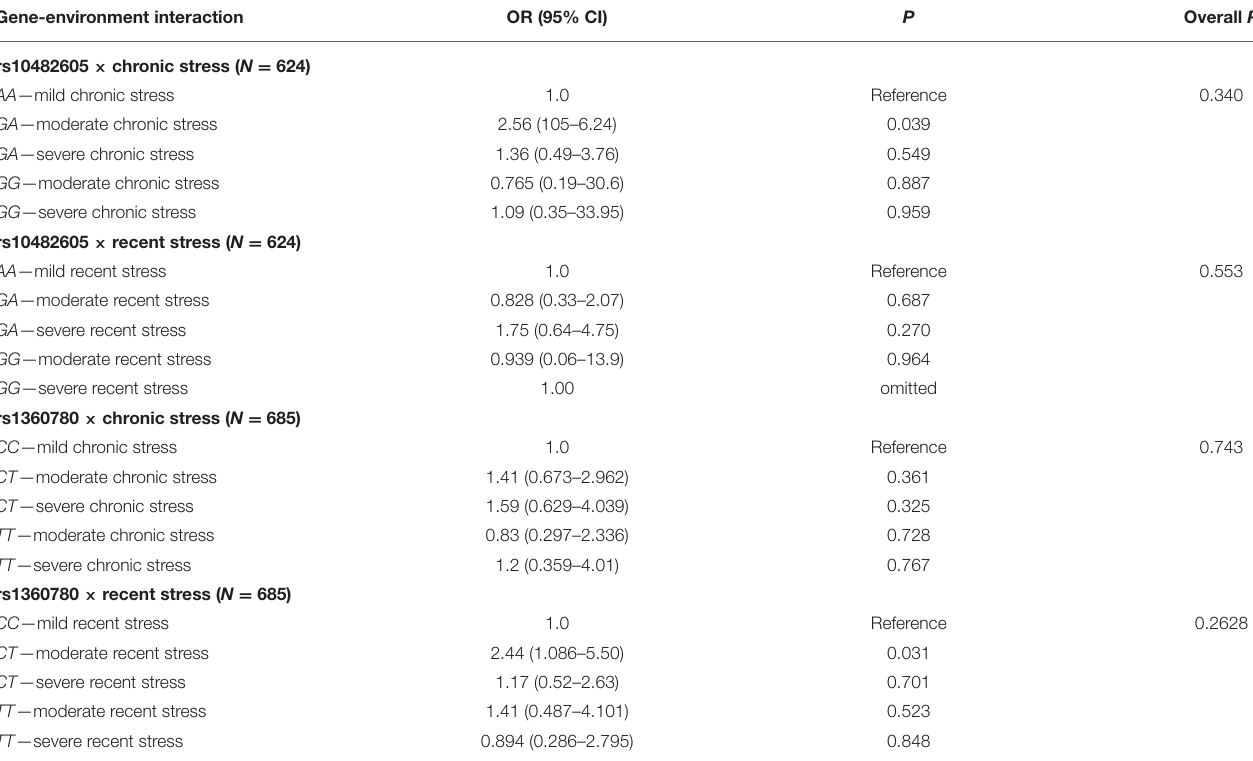
TABLE 5 | Gene-environment